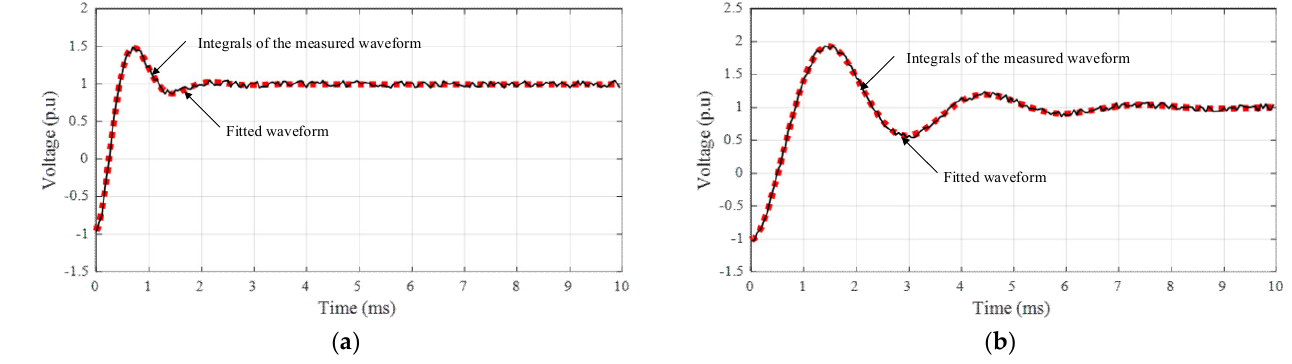
Figure 12. The measured waveforms in comparison with the fitted waveforms in a period ( a ) without the additional inductance, and ( b ) with the additional inductance.